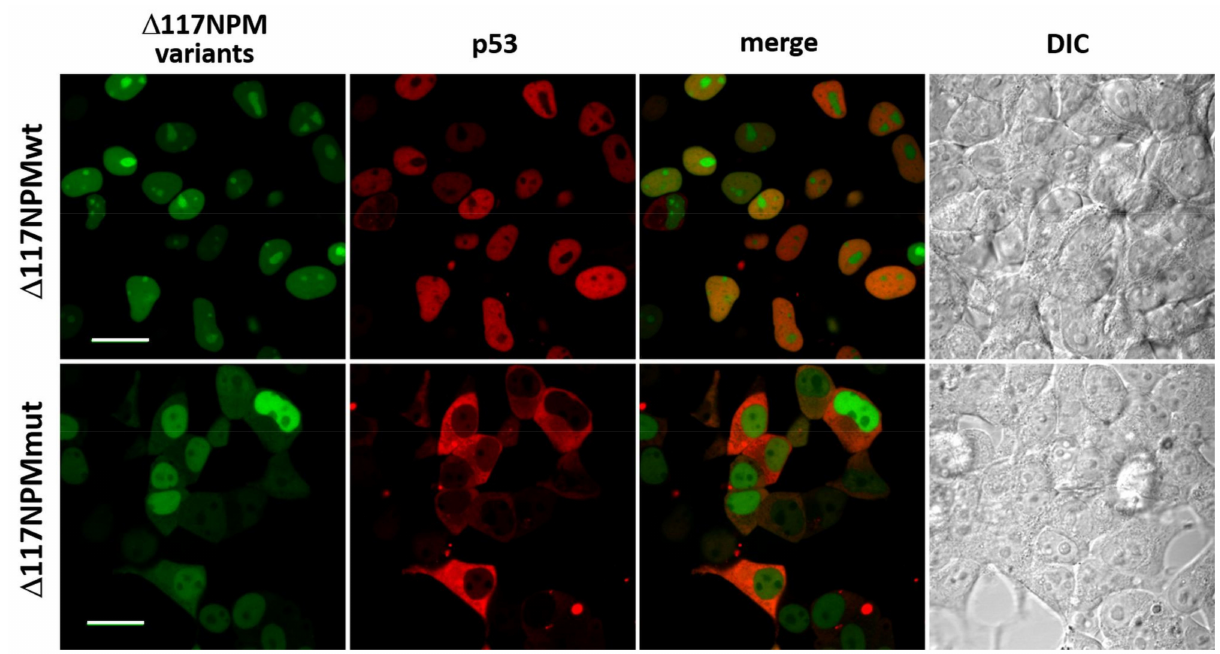
Figure 3. Localization of R_p53 co-expressed with eGFP-labeled NPM variants with truncated oligomerization N-terminus (AA1-117) in HEK-293T cells. Upper row—R_p53/G_ ∆ 117wt co-expression, lower row—R_p53/G_ ∆ 117mut co-expression, first